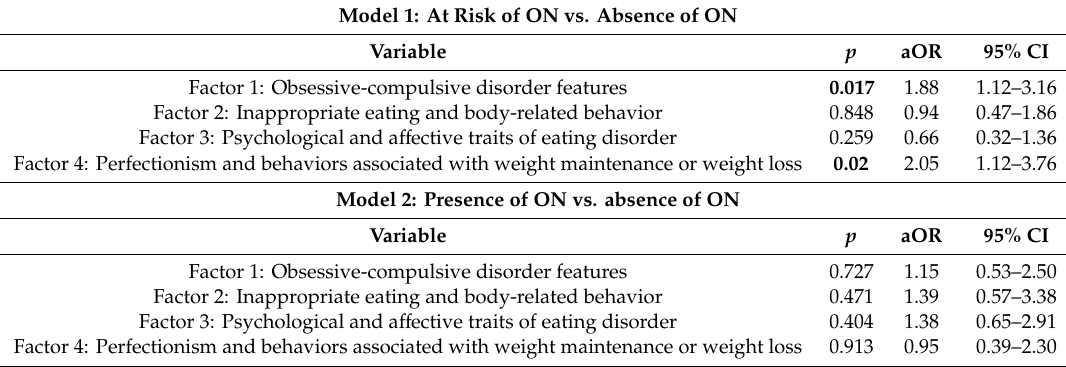
Table 7. Multivariable analysis: multinomial logistic regression taking the absence of orthorexia nervosa as the reference